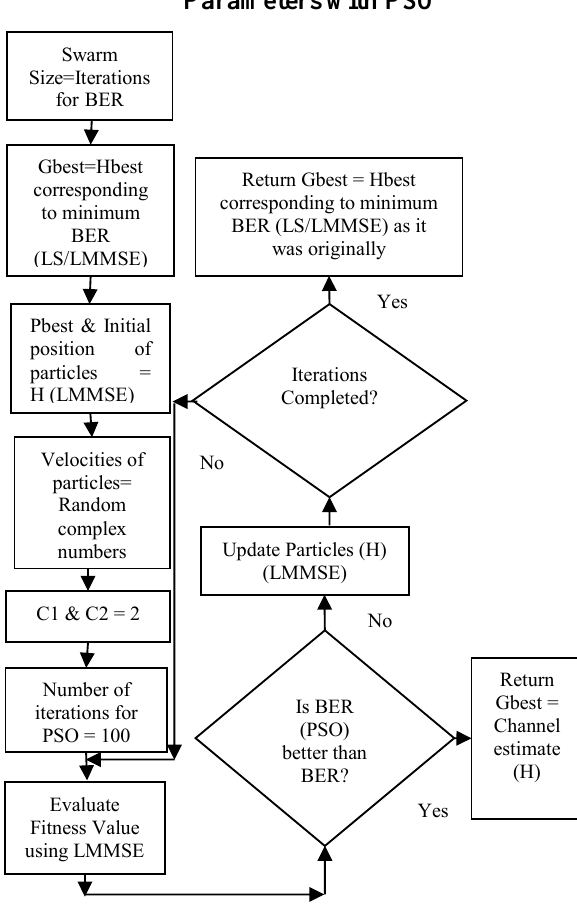
Figure 2: Flowchart of the novel approach to optimize BER using PSO